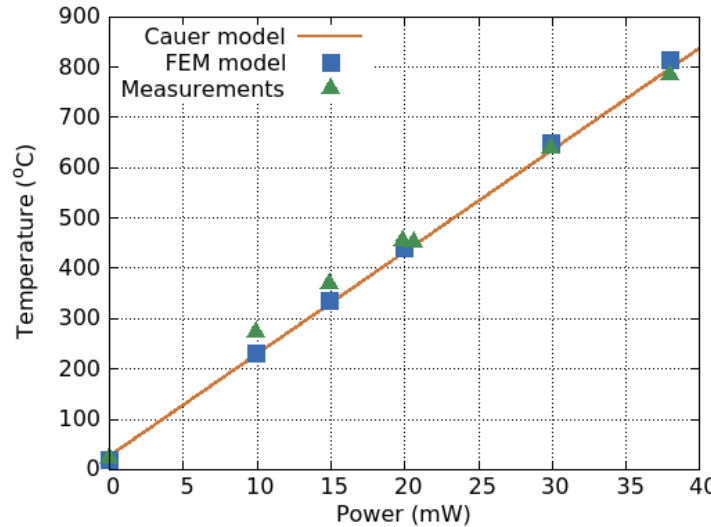
Figure 16. Experimental and simulated results for the temperature versus applied power relationship for a microheater design described in [17]. It is evident that the analytical Cauer model can reproduce the temperature-power relationship of an SMO